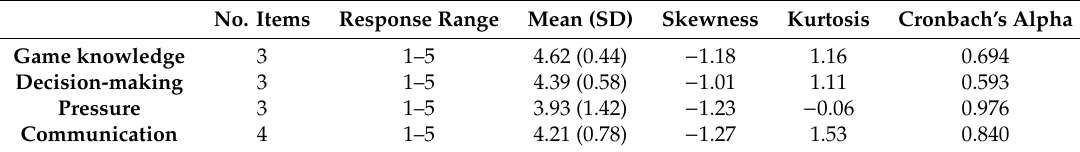
Table 2. Descriptive statistics and reliability of the four subscales of the referee self-e ffi cacy scale (REFS). No. Items